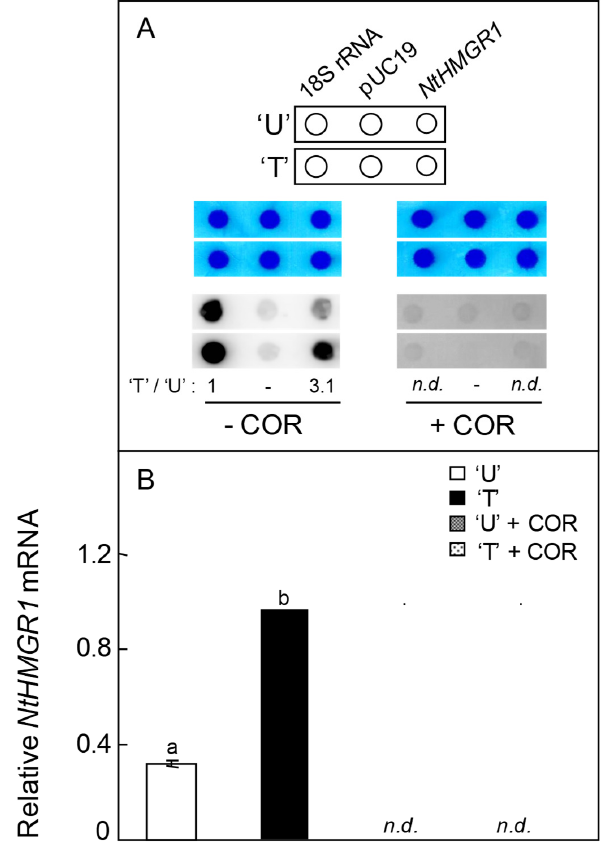
Figure 4. Measurement of NtHMGR1 transcriptional rate A. Approximately 100 ng of empty-vector DNA, pUC19 (negative-control), 18S rDNA (positive-control) and NtHMGR1 PCR amplicon were dot-blotted on nylon membranes. The blots were probed with α-[ 32 P] UTP-labelled nascent TRO transcripts derived from permeabilized nuclear-fractions of ‘U’ and ‘T’. As a control for nascent transcript synthesis inhibition, a pre-treatment of isolated nuclear-fraction of ‘U’ and ‘T’ with an optimized concentration (200 µg ml -1 ) of COR was also performed. The position of individual dot-blot DNA, methylene-blue stained dotted DNA (loading-control) and recognition of dotted DNA by hybridized labelled nuclear RNA of ‘U’ and ‘T’ are shown in the upper -, middle - and bottom -panel, respectively. The signal-intensity of hybridized nuclear RNA of NtHMGR1 for each sample was quantified by densitometry scanning of phosphoimages. The indicated ratio under the blot signifies the base-corrected nuclear RNA intensity between the indicated samples. B. Bar-graph indicates the relative signal-intensity of NtHMGR1 transcript with respect to corresponding 18S rRNA. Means ± SDs, n = 2, wherein data marked with different letters indicates the significant differences ( p≤0.05 ). n.d. - not detected, COR